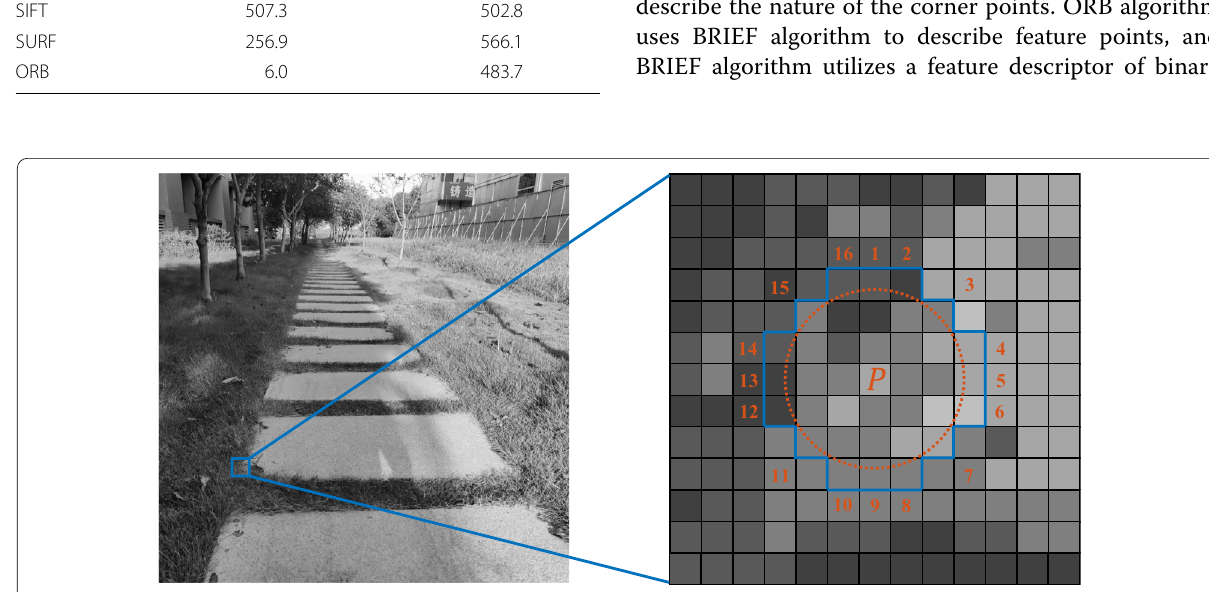
Figure 1 Corner point and the 16 surrounding